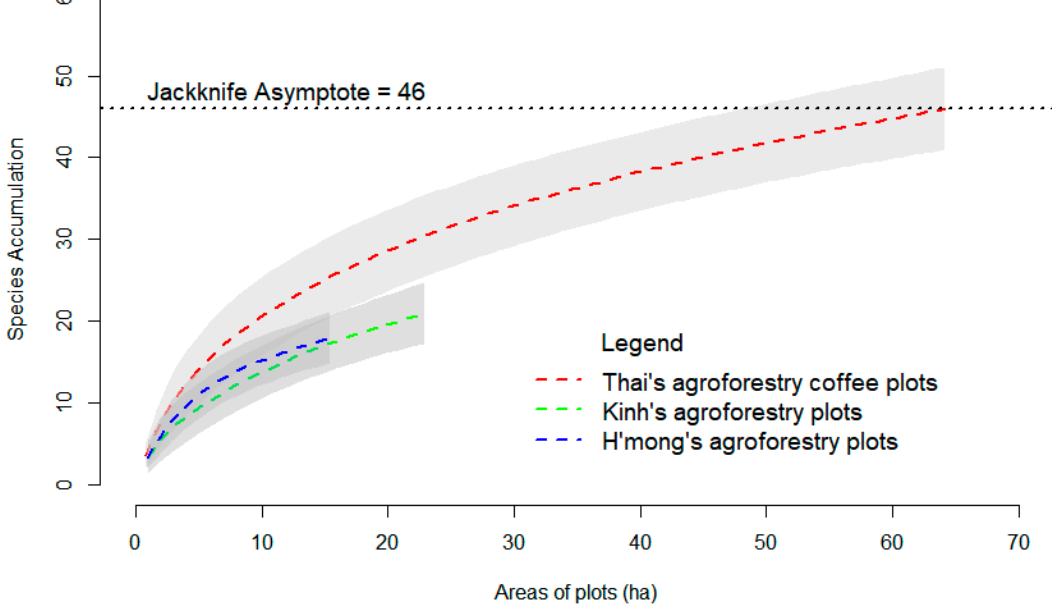
Figure 3. Species accumulations and first order Jackknife asymptotes by area from all coffee agroforestry plots of Thai, H’mong and Kinh ethnic